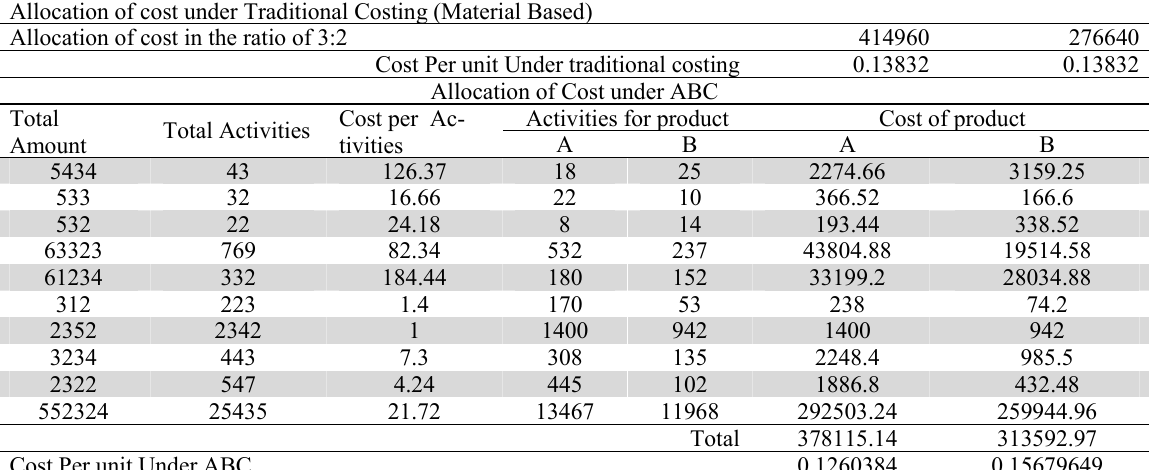
Allocation of overheads on traditional and ABC Basis Allocation of cost under Traditional Costing (Material Based) Allocation of cost in the ratio of